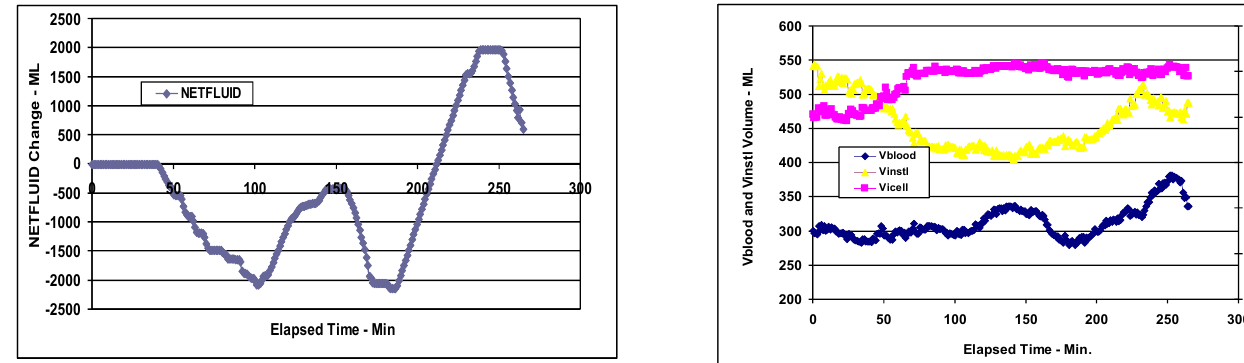
Fig. 10: Compartment volumes vs. elapsed time.